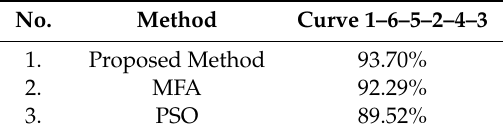
Figure 14. Dynamic power tracking evolution of ( a ) proposed method, ( b ) MFA, and ( c ) PSO. Table 6. Tracking e ffi ciency of dynamic